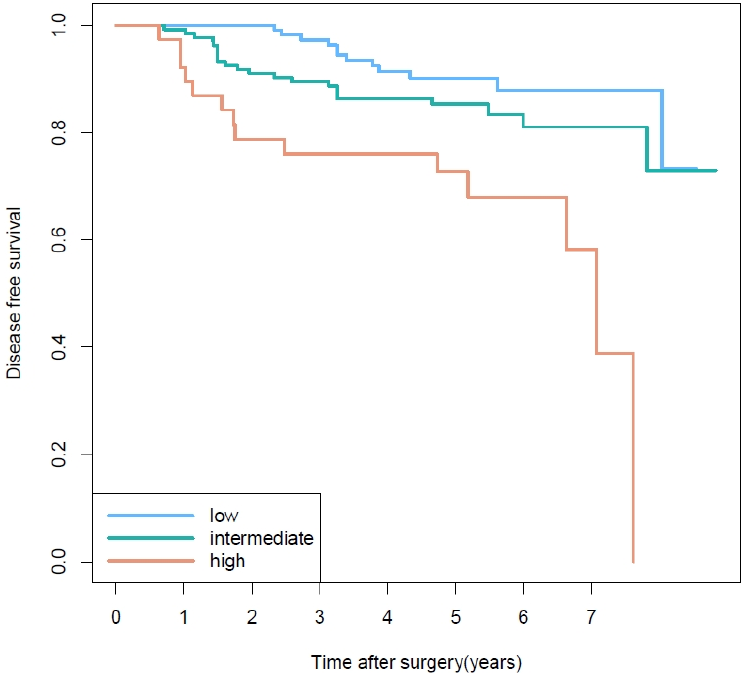
Figure 2. Disease-free survival curves based on the second most predominant pattern when the most predominant pat- tern is intermediate grade. Survival curves were significantly different among the three second most predominant sub- groups ( p = 0.004).